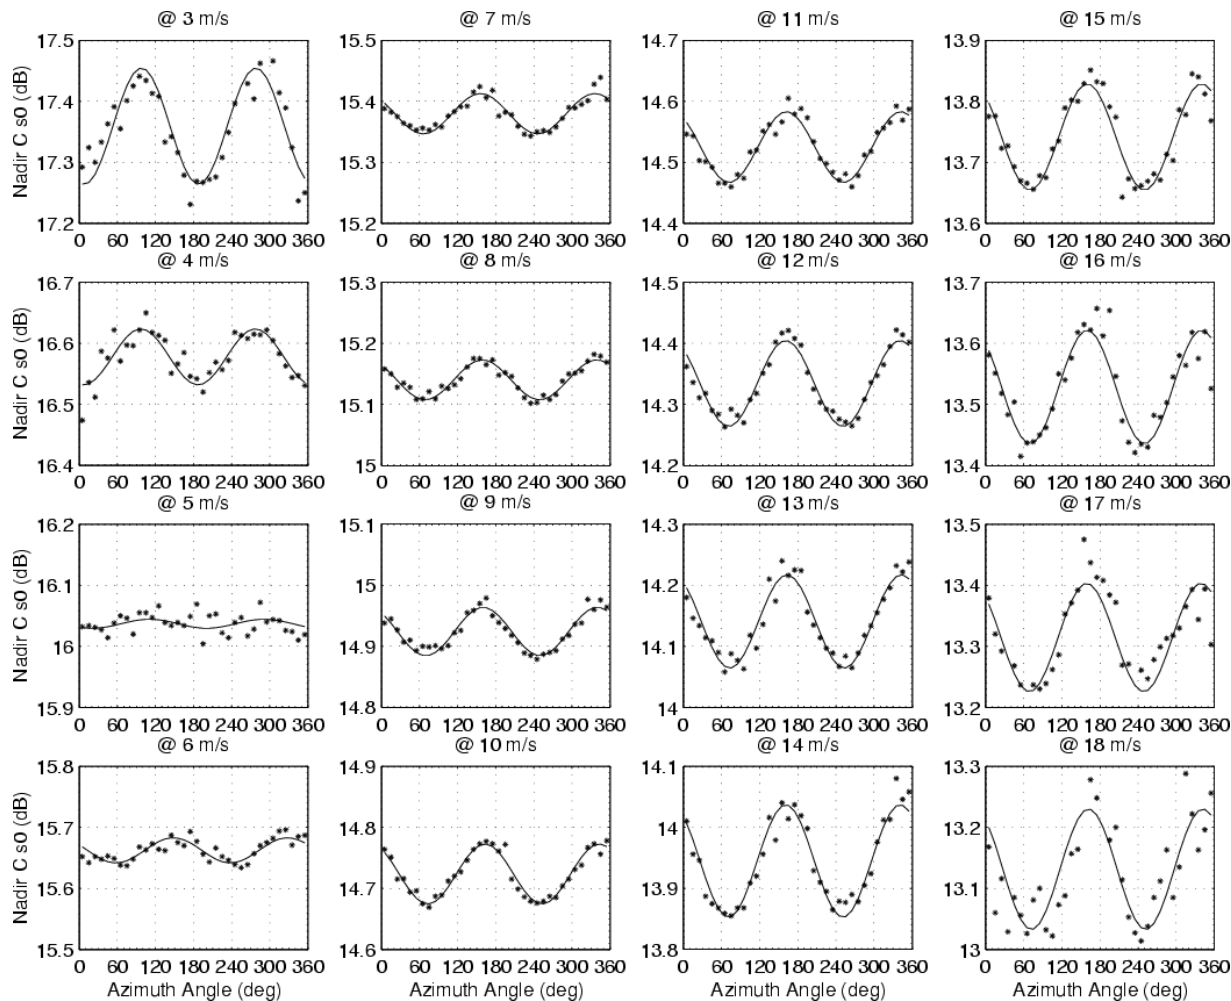
Figure 2. Same as Figure 1 for C-band altimeter radar